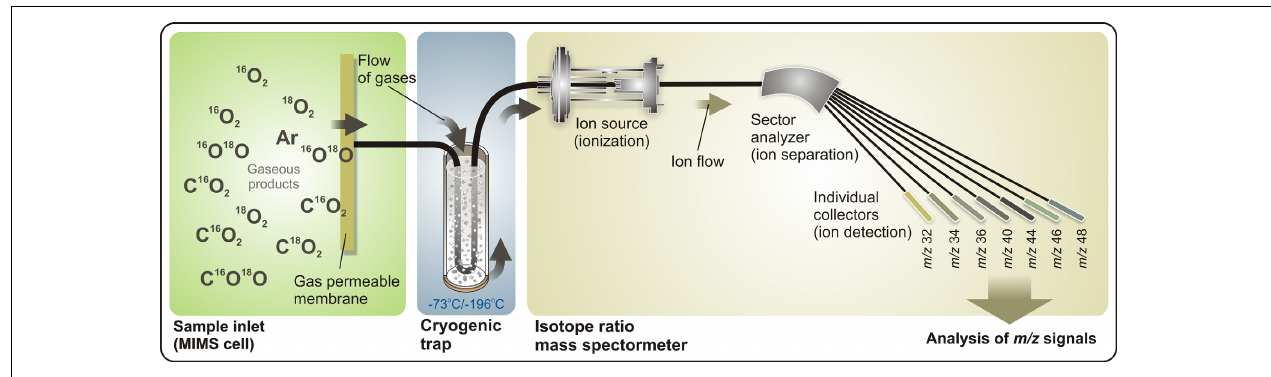
FIGURE 2 | Representation of a TR-IR-MIMS set-up. Gaseous products, produced by sample suspension (for instance, by PSII samples) in the cell, penetrate through a gas-permeable membrane into a high-vacuum space, pass through a cryogenic trap (which removes water vapor from a flow of gaseous analytes), and enter the isotope ratio mass spectrometer. Here,